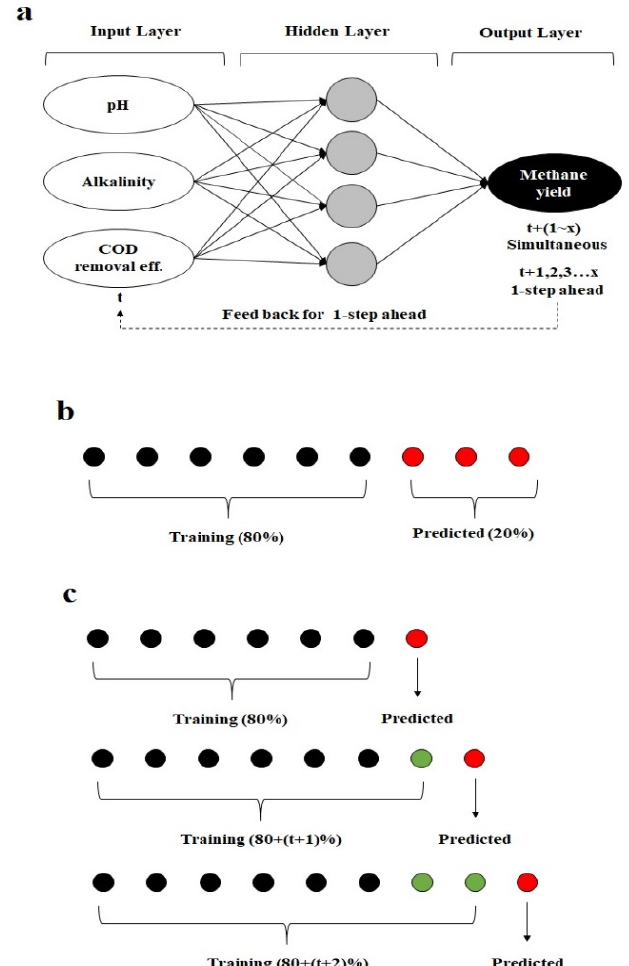
Figure 1. Schematic diagrams for understanding the ( a ) machine learning algorithm, ( b ) multi-step ahead method, and ( c ) 1-step ahead with retraining method [21].